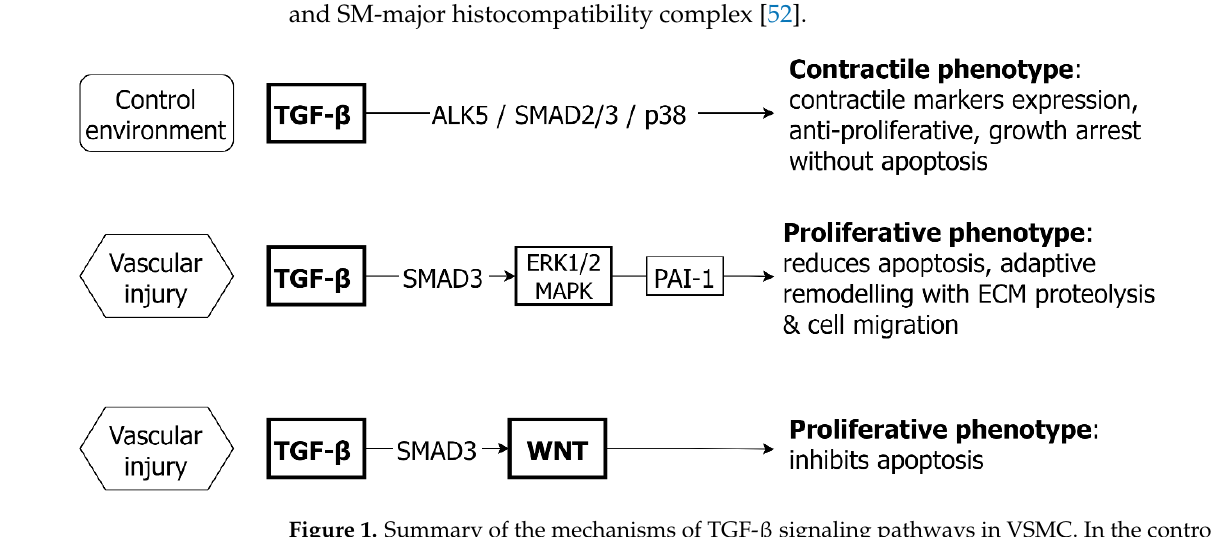
Figure 1. Summary of the mechanisms of TGF- β signaling pathways in VSMC. In the control envi- ronment, TGF- β supports the contractile phe notype by signaling through ALK5/SMAD2/3/p38. Fol- lowing vascular challenge, TGF- β stimulation in presence of increased SMAD3 is associated with transactivation of EGFR and activation of ERK1/2/MAPK/PAI-1, resulting in change is phenotype with secretion of MMP and ECM remodeling. Another injury response in presence of increased SMAD3 is receptor independent activation of WNT/β -catenin, with associated reduction in VSMC apoptosis.